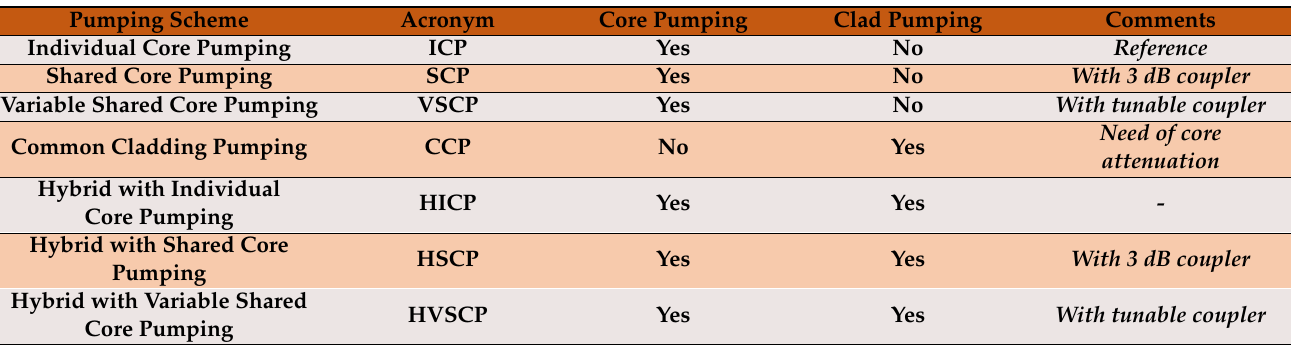
Table 8. Available Pumping Schemes